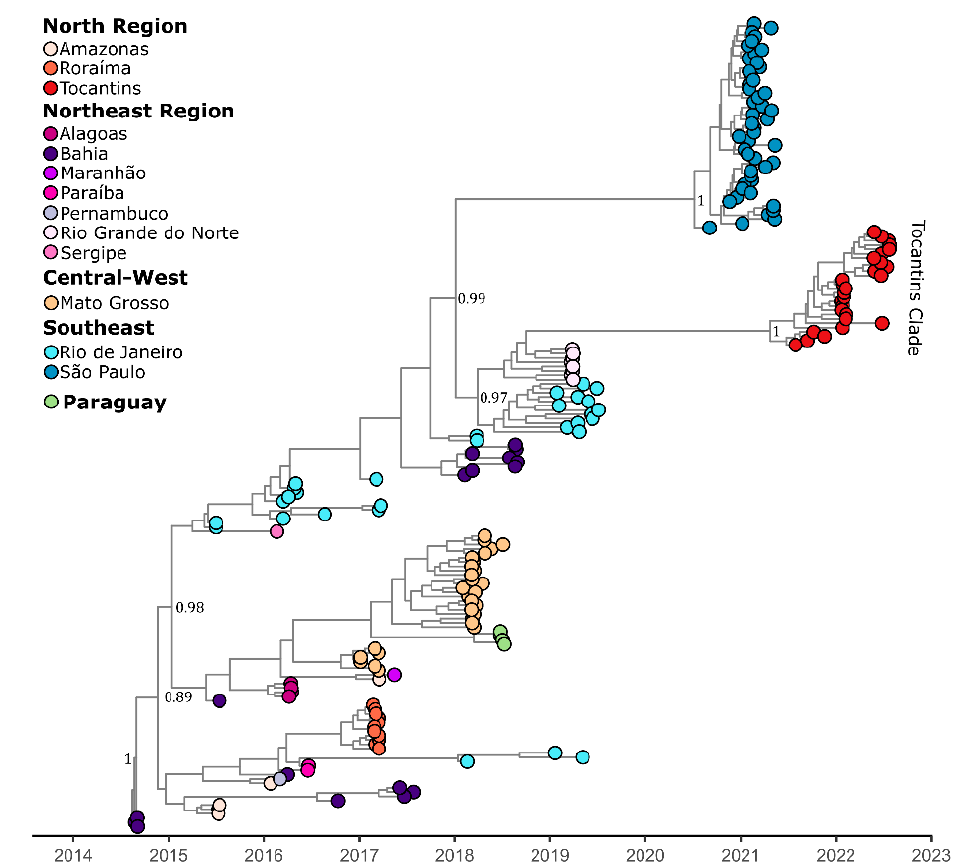
Figure 2. Time-scaled phylogenetic tree of 186 complete and near-complete CHIKV genome sequences from the ECSA genotype sampled in Brazil and Paraguay. Colors represent different sampling locations according to the legend on the left of the tree. Genomes reported in the presented study are colored in red.